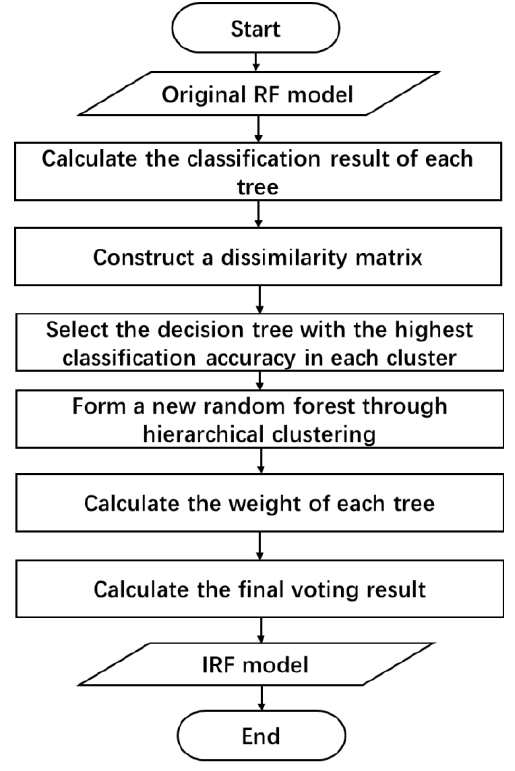
Figure 3. Flowchart of the algorithm.